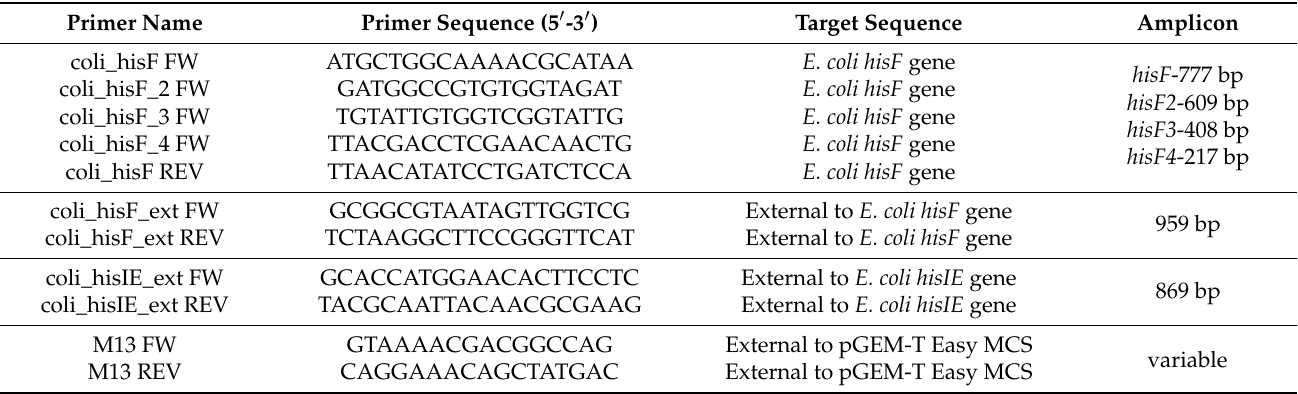
Table 1. Primers used in this